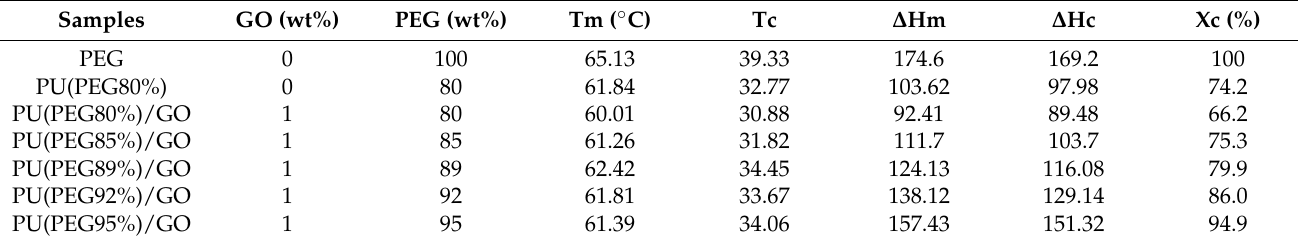
Table 3. DSC data of PEG, PU and PU/GO .